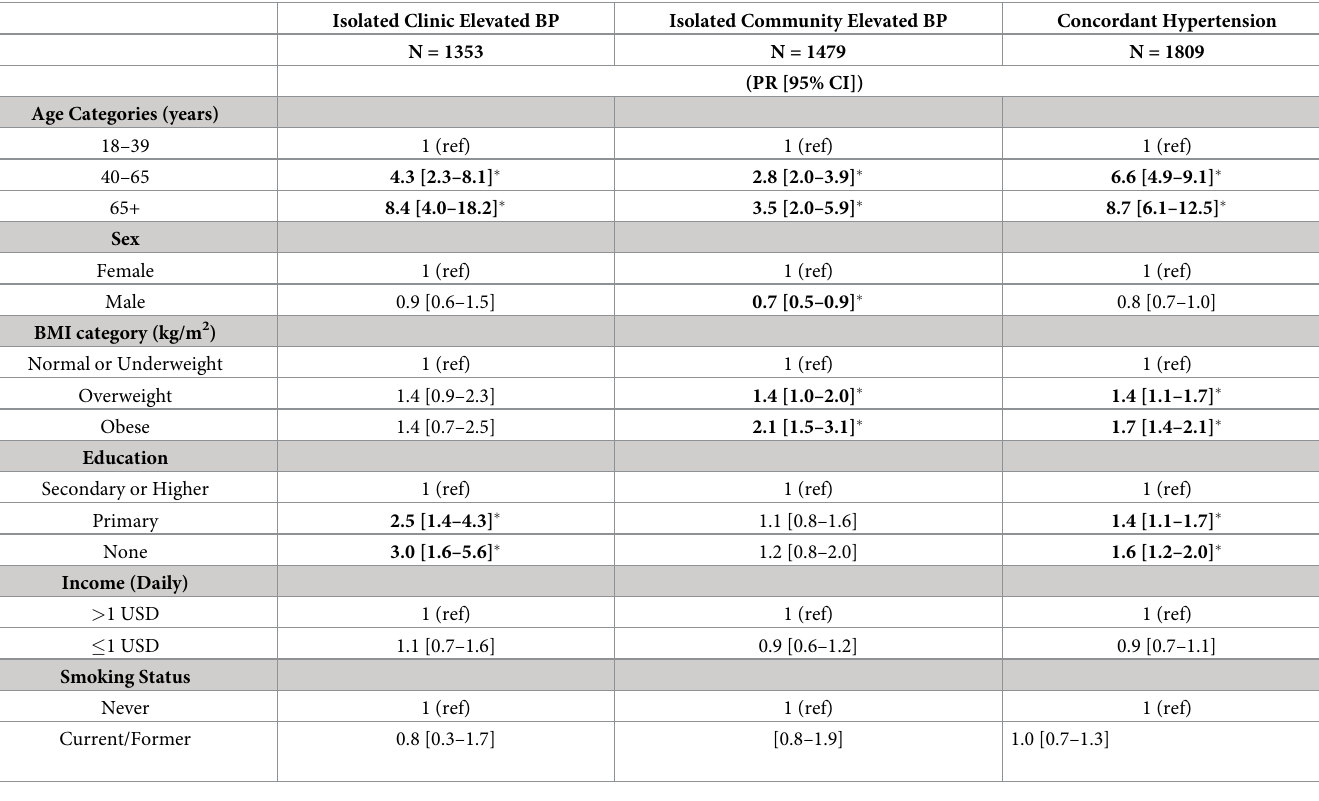
Table 3. Multivariable logistic regression models assessing factors associated with isolated elevated clinic blood pressure, isolated elevated community blood pres- sure, and concordant hypertension compared to participants with concordant normotension. Isolated Clinic Elevated BP Isolated Community Elevated BP Concordant Hypertension N = 1353 N = 1479 N =